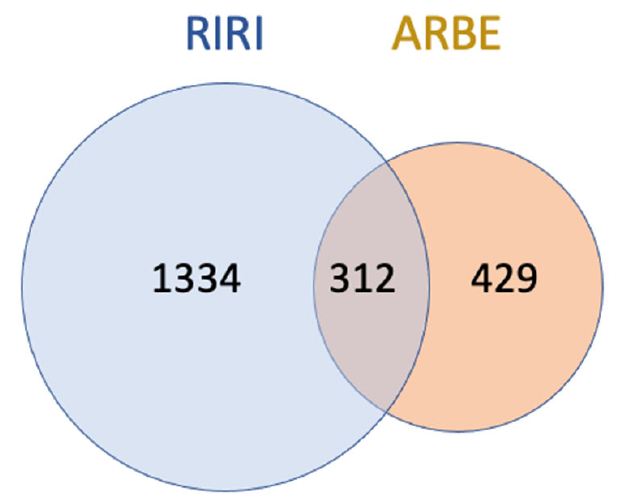
Figure 3. Overlapping molecular targets between RIRI and major compounds of ARBE. ARBE, Agathis Robusta bark extract; RIRI, renal ischemia reperfusion injury.